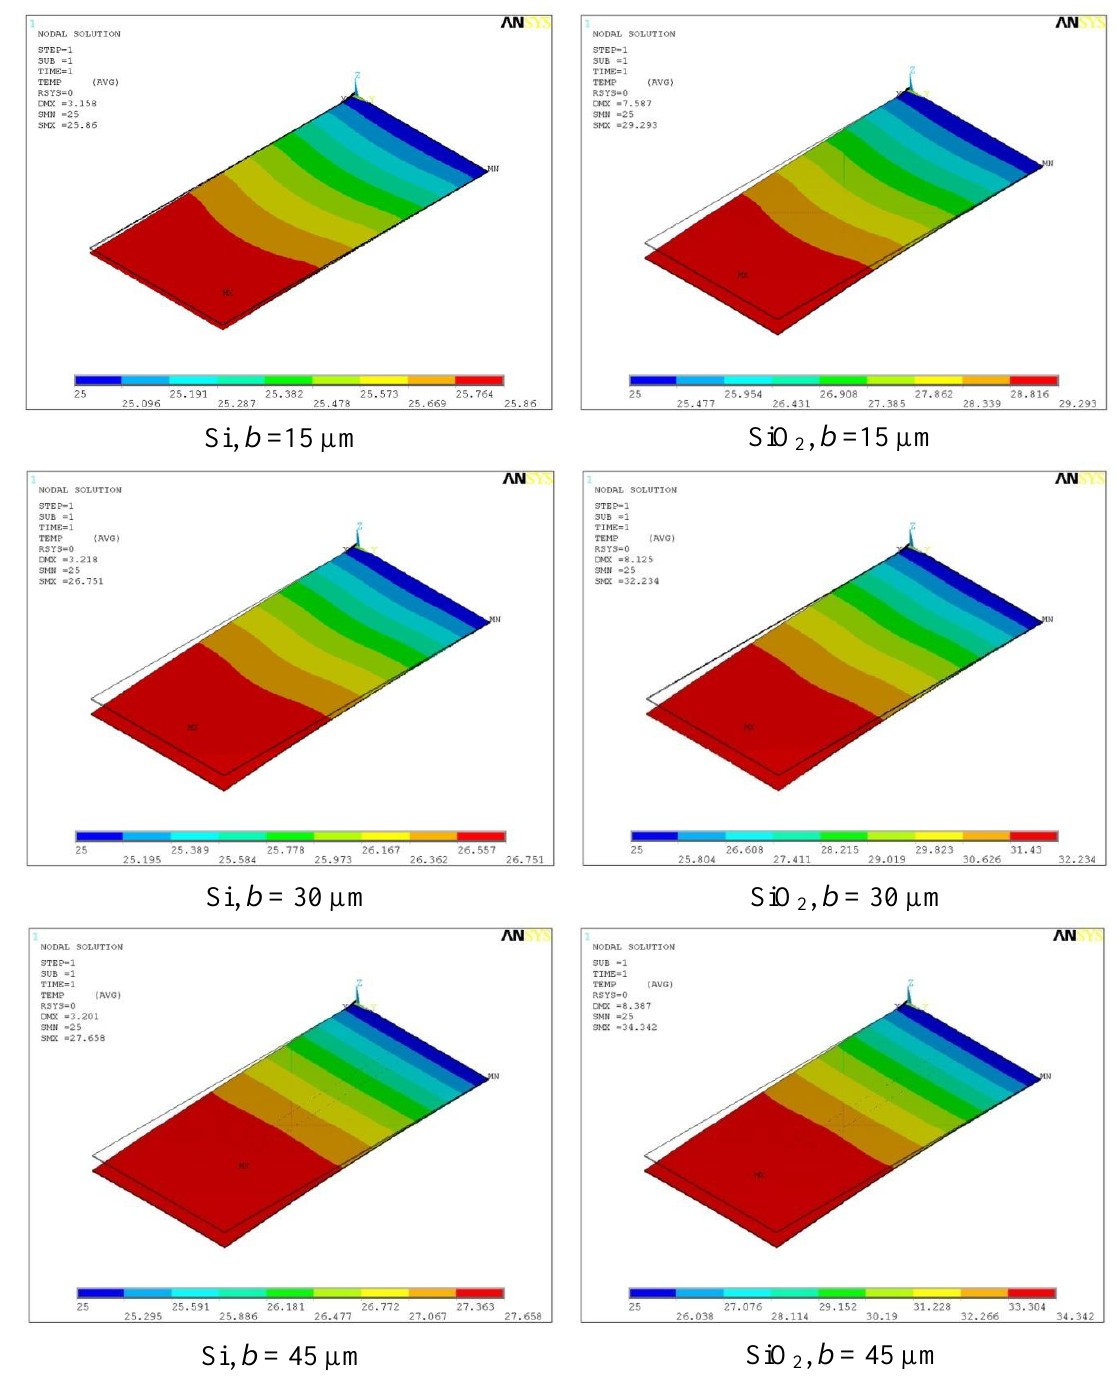
Figure 7. Temperature profile in silicon and silicon dioxide piezoresistive microcantilevers at V = 5 b